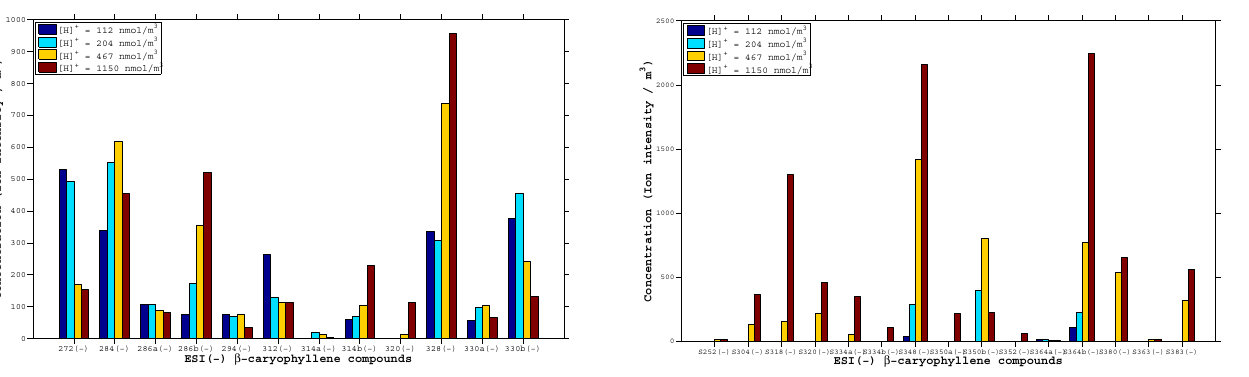
Fig. 3. Concentration of compounds detected by ESI in negative ion mode in the series of β -caryophyllene/NO x irradiation experiments. Chemical formulas and proposed chemical structures of these com- pounds are given in Table 3.